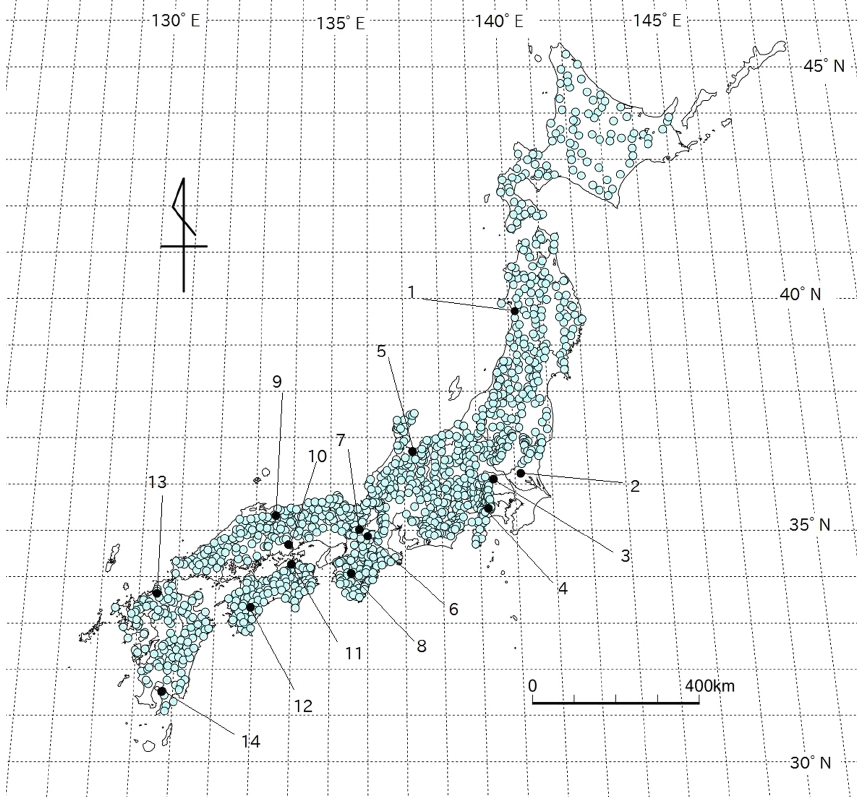
Figure 1. Index map showing locations of the 1278 stream water sampling points and the 14 sampling stations of precipitation. Light blue circles: stream water sampling points. Black circles: precipitation sampling station. The station numbers correspond to those in Table